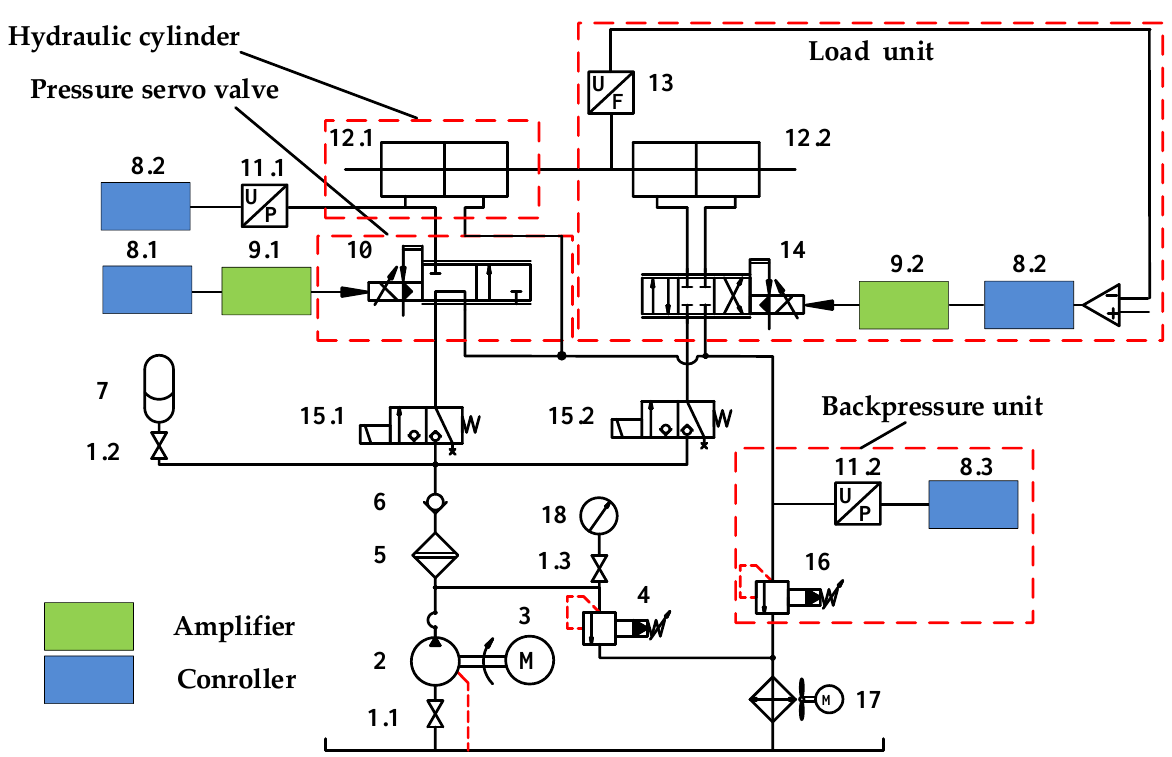
Figure 5. Hydraulic principle of experimental platform.